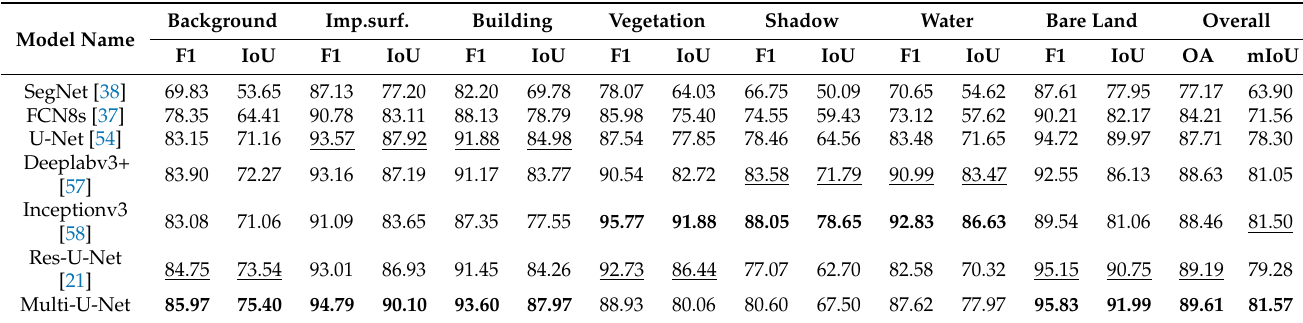
Table 1. The quantitative results using the deep learning models on the Gaofen-2 test data set. The bold values denote the best result, and the underlined values denote the second best result achieved by models.